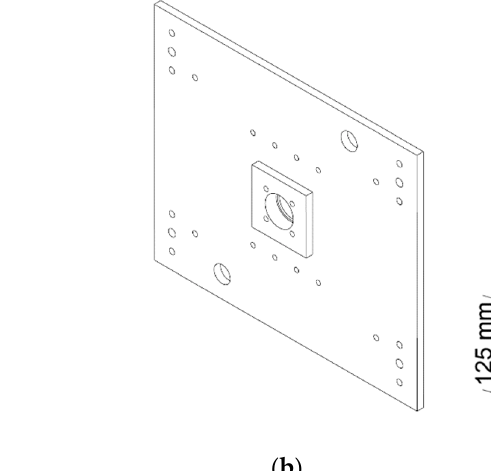
Figure 4. Intermediate solution for the alignment of the plates: ( a ) Frontal view—detail of the visibility and accessibility to the specimen area; ( b ) Lateral view—lateral plate.